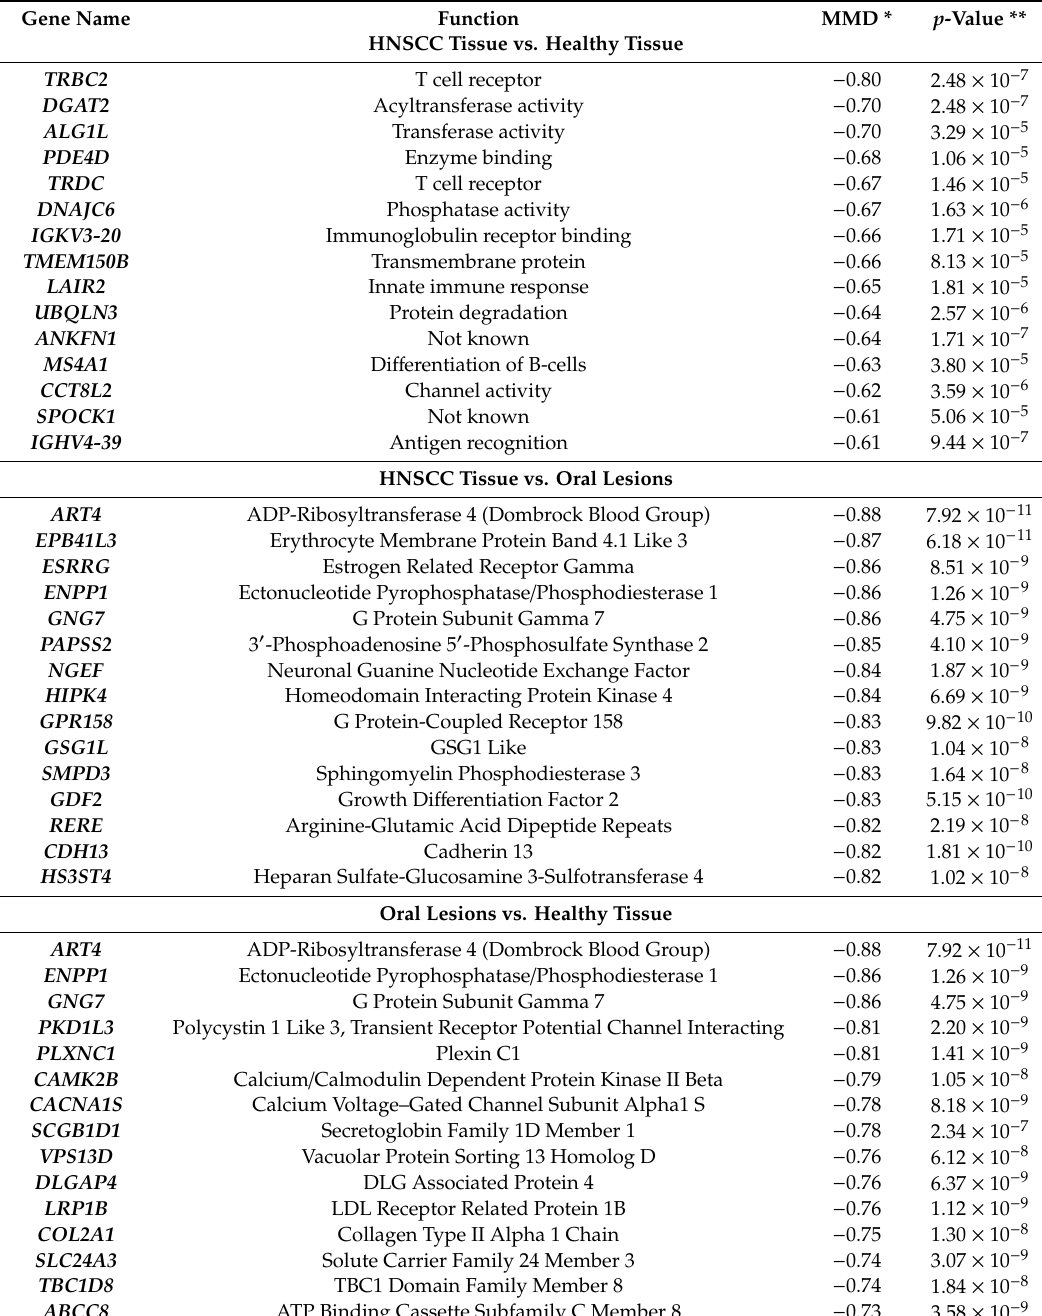
Table 2. Hypomethylated gene promoter methylation in HNSCC tissue compared to control healthy tissue and potentially premalignant oral lesions, and in potentially premalignant oral lesions compared to control healthy tissue. The list is merged of top fifteen di ff erentially methylated genes according to the extent of methylation di ff erence